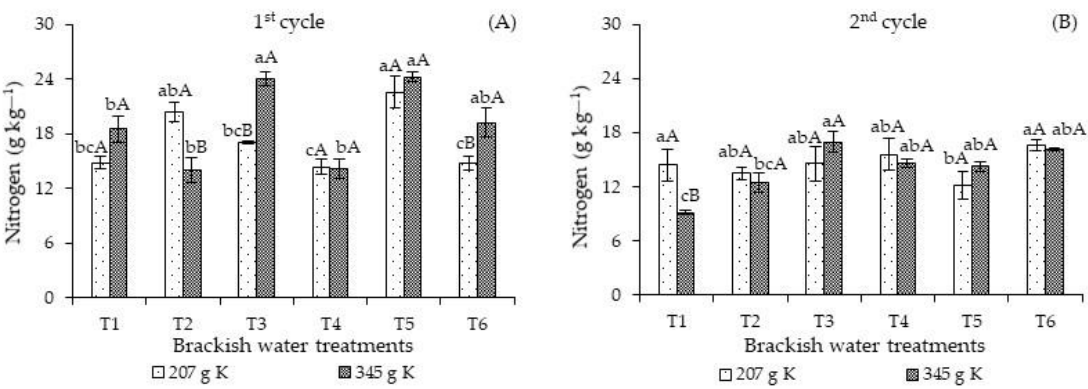
Figure 1. Leaf nitrogen concentrations of Passiflora edulis Sims as a function of the interaction ISBW × KD in the first ( A ) and second ( B ) cycle. Standard error of the mean ( n = 4); Means followed by different lowercase letters indicate a significant difference between the irrigation strategies with brackish water for the same KD ( p ≤ 0.05), and different uppercase letters indicate a significant difference between potassium levels for the same irrigation strategy. T1—irrigation with low-salinity water during the entire cultivation cycle; salt stress in the following stages: T2—vegetative; T3— flowering; T4—fruiting; T5—vegetative and flowering; T6—vegetative and fruiting.